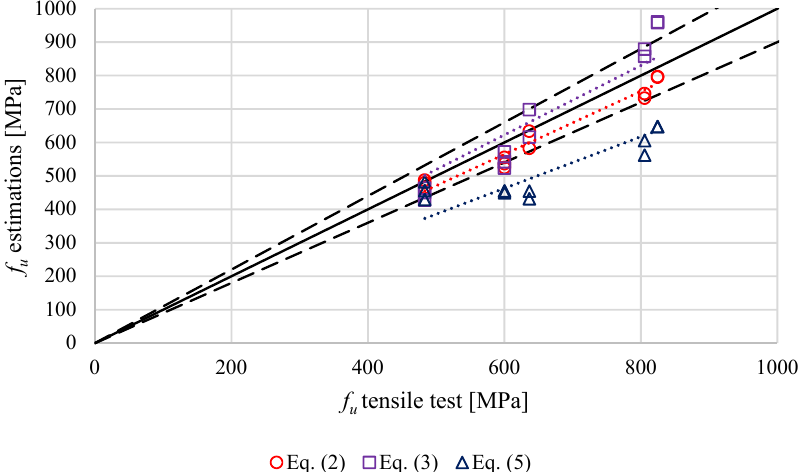
Figure 14. Comparison of ultimate tensile strength values determined in the tensile tests and SPT (blue) or HV (red) estimations. Linear trendlines as dotted